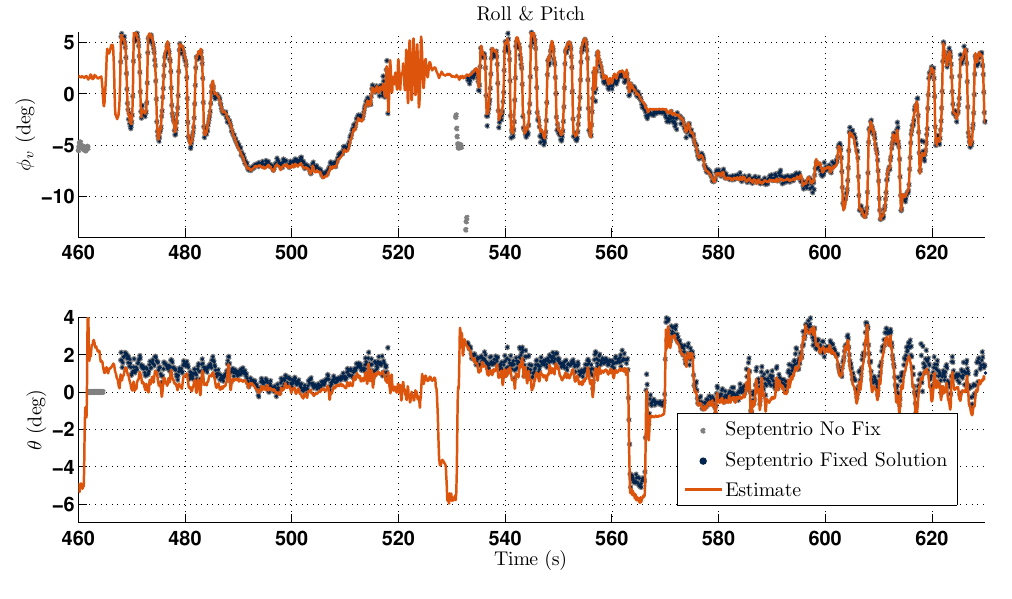
Figure 9. Roll and pitch comparison on the NCAT oval track 15-state cascaded